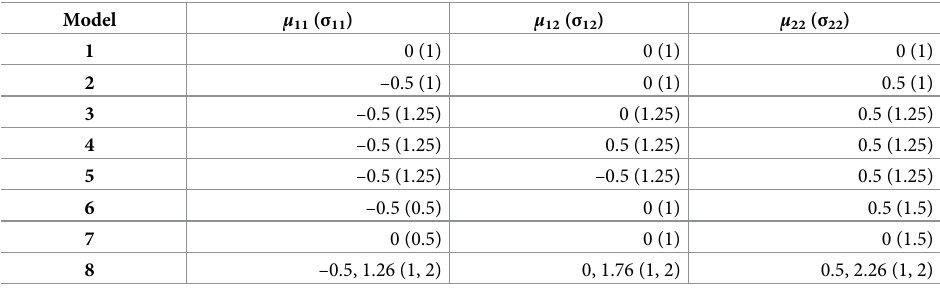
Table 2. Simulation generating Models †